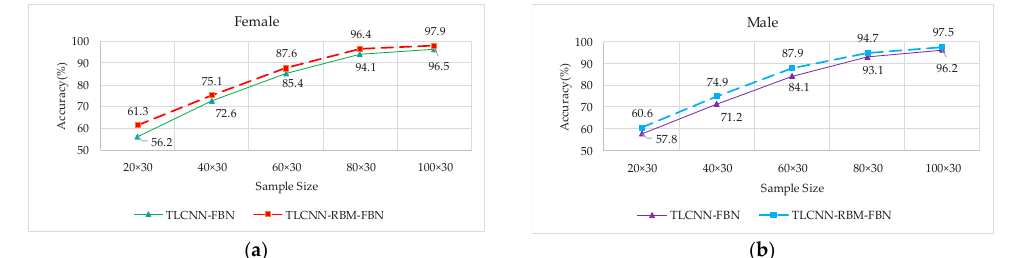
Figure 13. The accuracy for voiceprint recognition under different retraining sample sizes. ( a ) Comparison of accuracy based on female, ( b ) comparison of accuracy based on male.